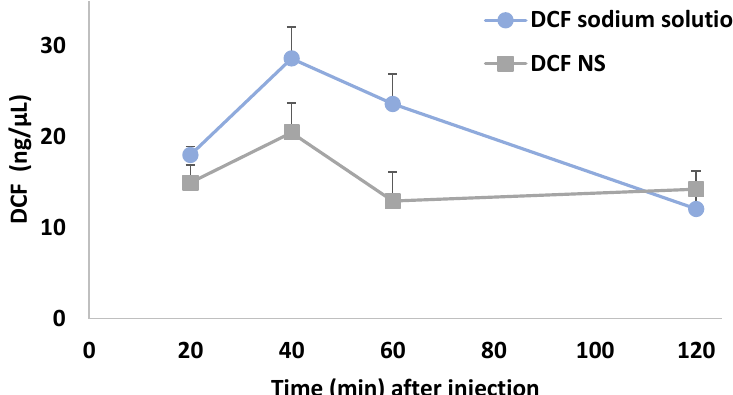
Figure 7. Concentration versus time curves of plasmatic DCF levels. Results are shown as mean ± SEM of the changes in DCF plasma concentrations after administration of DCF sodium solution (blue circles, n = 4) or DCF NS (grey squares, n = 5). Results analyzed by two-way ANOVA; Bonferroni’s post hoc test.